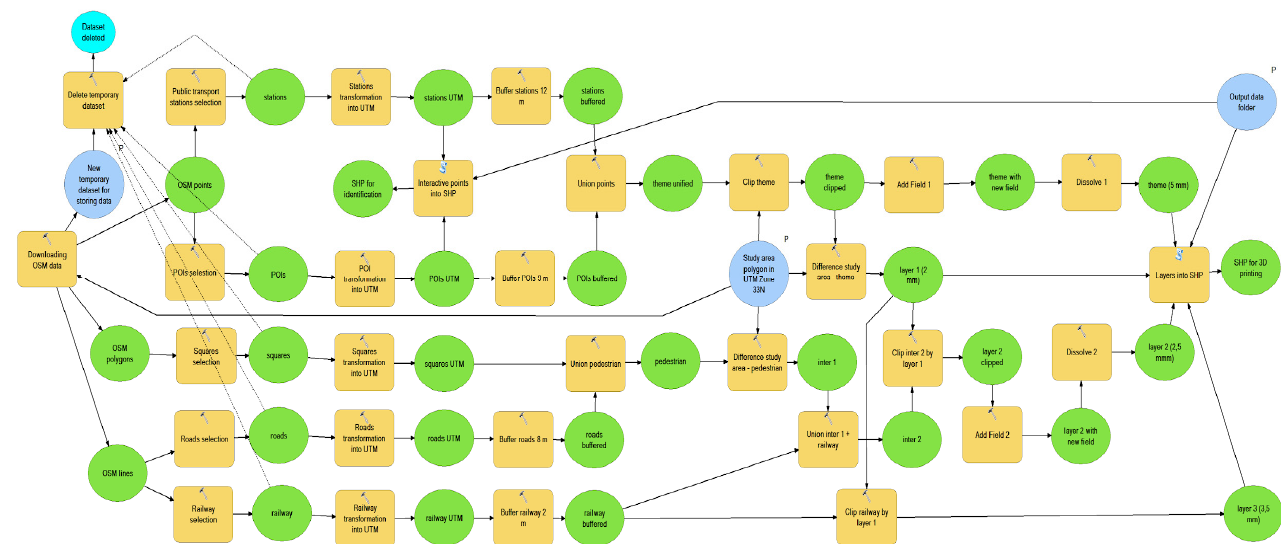
Figure 7. Illustration of the complexity of the data processing scheme for the Public Transport map type (link to the toolbox with all three Model Builder models with readable captions is available in the Supplementary Materials section).